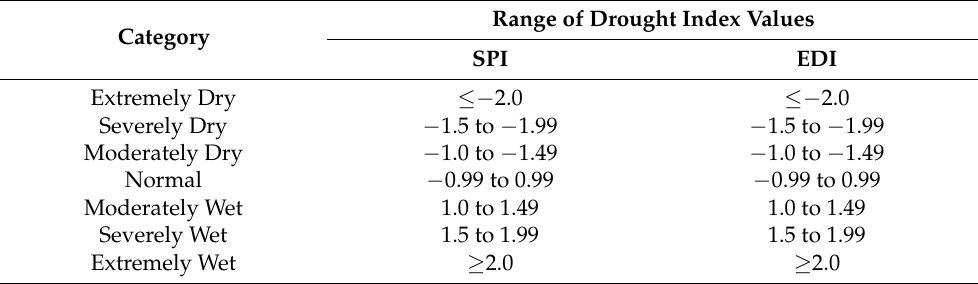
Table 1. Different categories of SPI and EDI values for drought severity (Byun and Wilhite